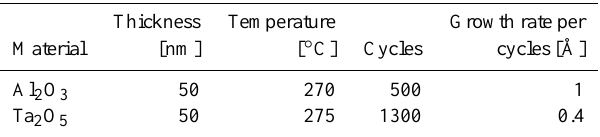
Figure 13. SEM image of boundary between polyimide–epoxy composite and chip surface with an ALD layer (not visible) over the entire area. Table 1. Process parameters for the deposition of the passivation